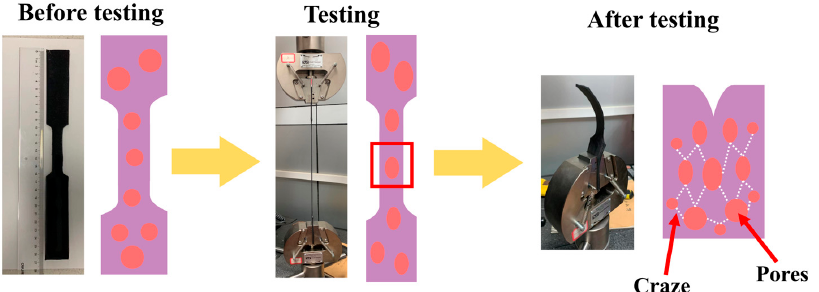
Figure 6. Schematic diagram of polyurea tensile fracture. (Specimen drawing and specimen schematic diagram before testing; Specimen drawing and specimen schematic diagram in testing; Specimen drawing and specimen schematic diagram after testing.)